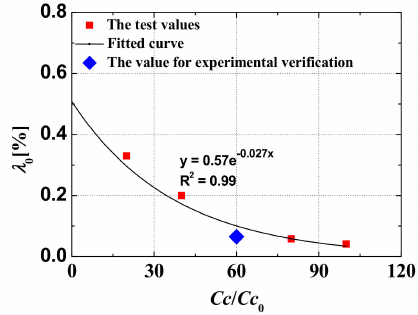
Figure 9. The relationship between the parameter λ 0 and cement content Cc